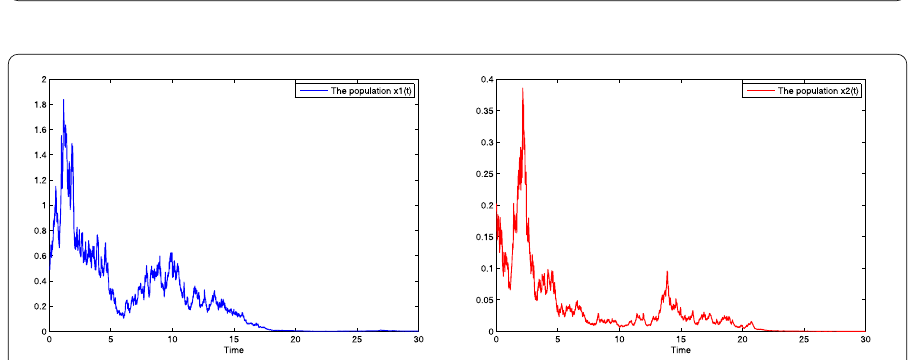
Figure 8 The time series of system (4) with σ 2